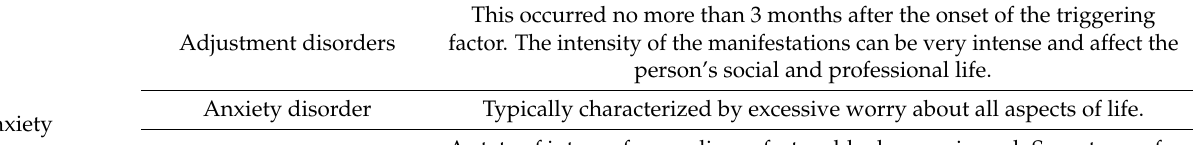
Table 4. Neuropsychiatric